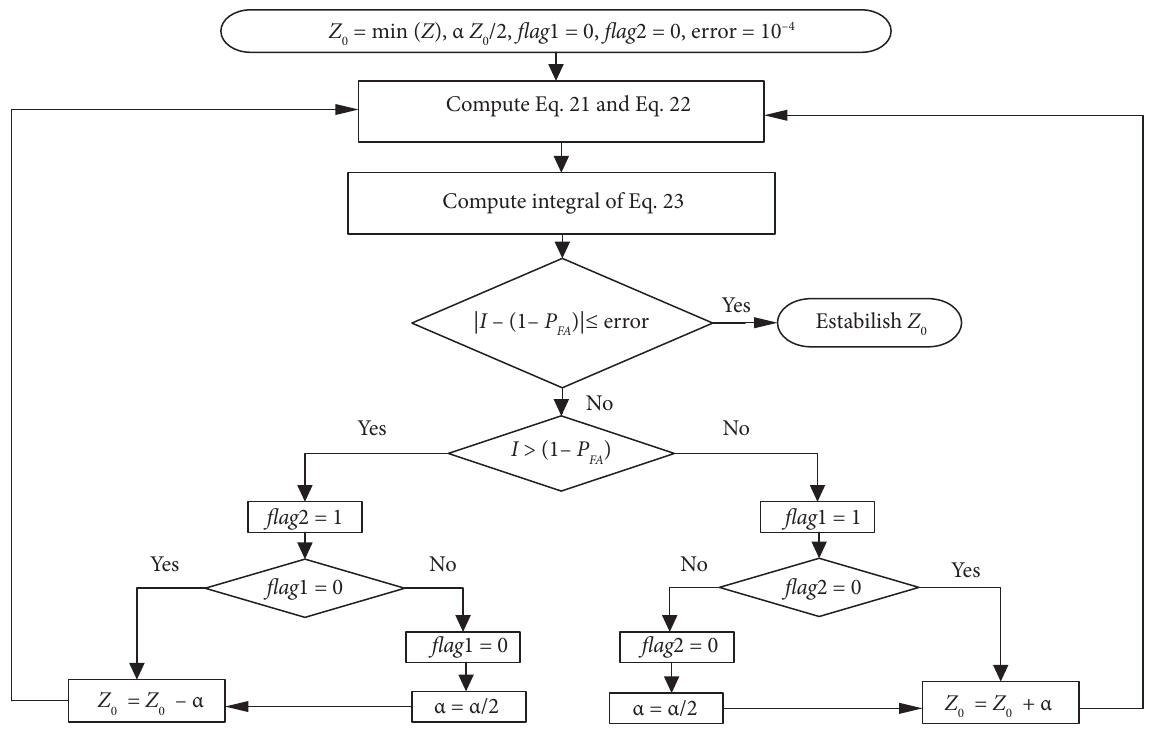
Figure 4. Flowchart of the algorithm to compute Z